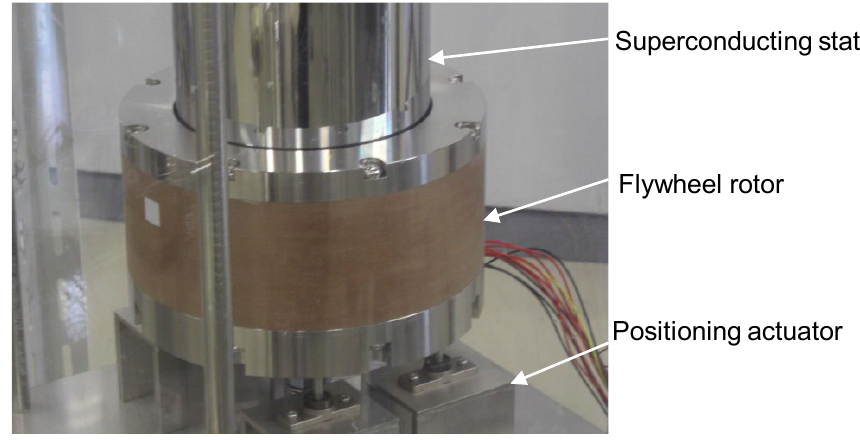
Figure 3. Flywheel rotor attached to the bottom end of the superconducting stator.